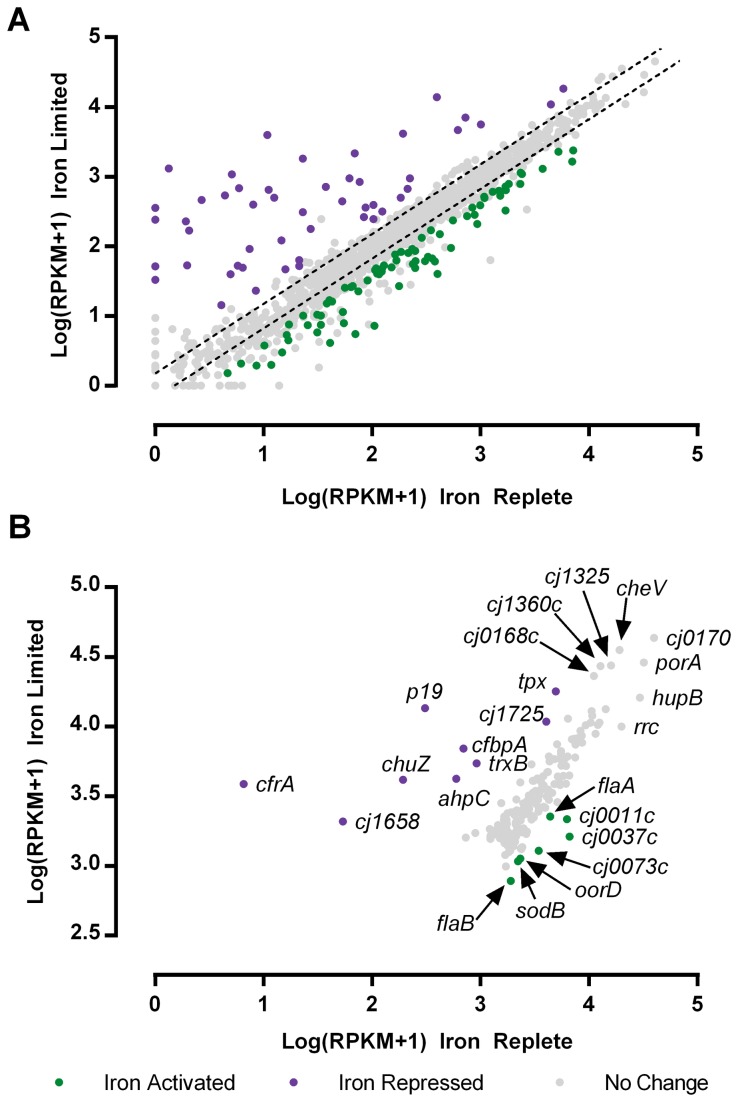
Differentially expressed genes under iron limitation.The average Log(RPKM+1) value for each gene was calculated under iron limited and iron replete conditions and plotted above. Significantly differentially expressed genes (p<0.01) are highlighted in green (iron activated) or purple (iron repressed) (Panel A). The hashed bars represent 1.5 fold differences in gene expression under each condition. The 90th percentile of the most highly expressed genes were plotted separately to compare the most highly expressed genes under iron limited and iron replete conditions (Panel B).